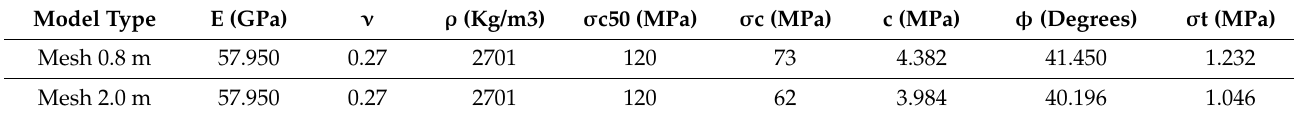
Table 3. Intact rock properties from literature.